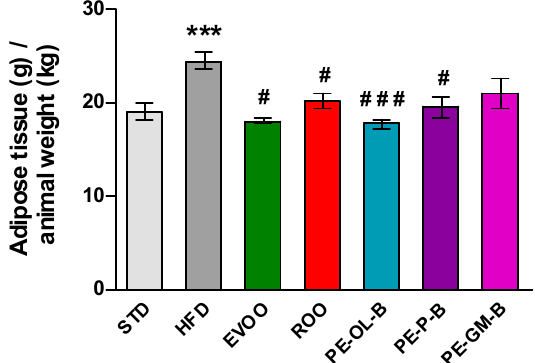
Figure 4. Ratio of adipose tissue (g) in relation to animal weight (kg) after 3 weeks of treatment with different diets. * indicates a statistically significant difference between the HFD group and the STD group. # indicates statistically significant difference vs. HFD. Single symbol corresponds to p ≤ 0.05. Triple symbol corresponds to p ≤ 0.005.